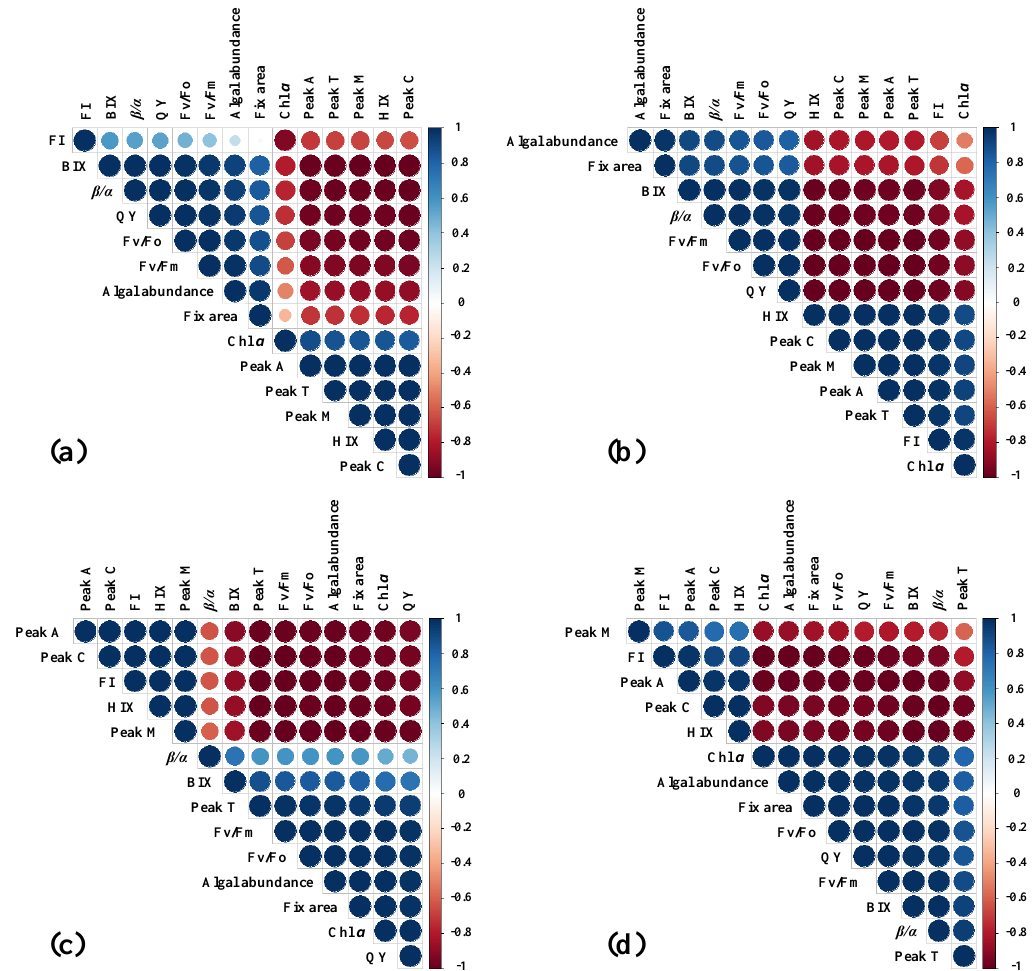
Figure 6. Correlation analysis between different variables of S. dohrnii with different treatment in artificial seawater. ( a – d ) are represented as Blank, SA, SZ, and SAZ, respectively. Note the color and size of the pie indicate the correlation coefficient. The blue color indicates positive correlation and red color indicates negative correlation.